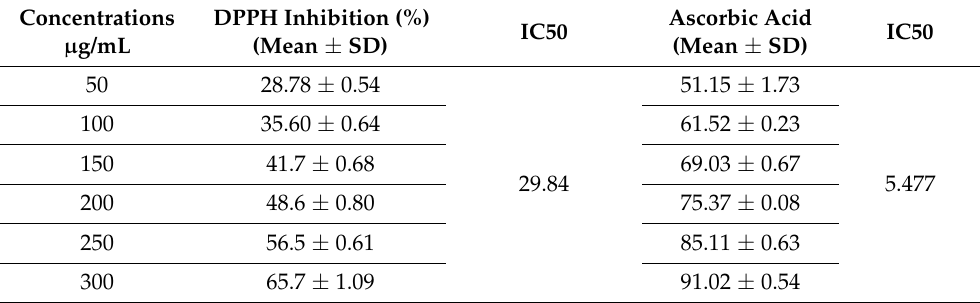
Table 2. Free radical scavenging activity of ZnO NPs of aqueous fraction of L. edodes . Concentrations